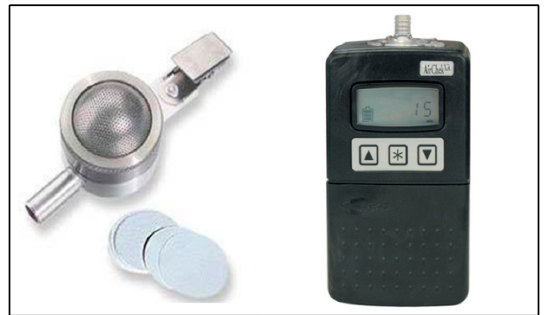
Figure 1. Portable (wearable) SKC Button Sampler (left) connected to the AirChek XR5000 pump (right) as used for near-patient air sampling in this study. The manufacturer’s sampling rate was fixed at 4 L/min. (Available from http://www.skcltd.com/index.php/uncategorised-articles/212-bio- aerosol-sampling-products).